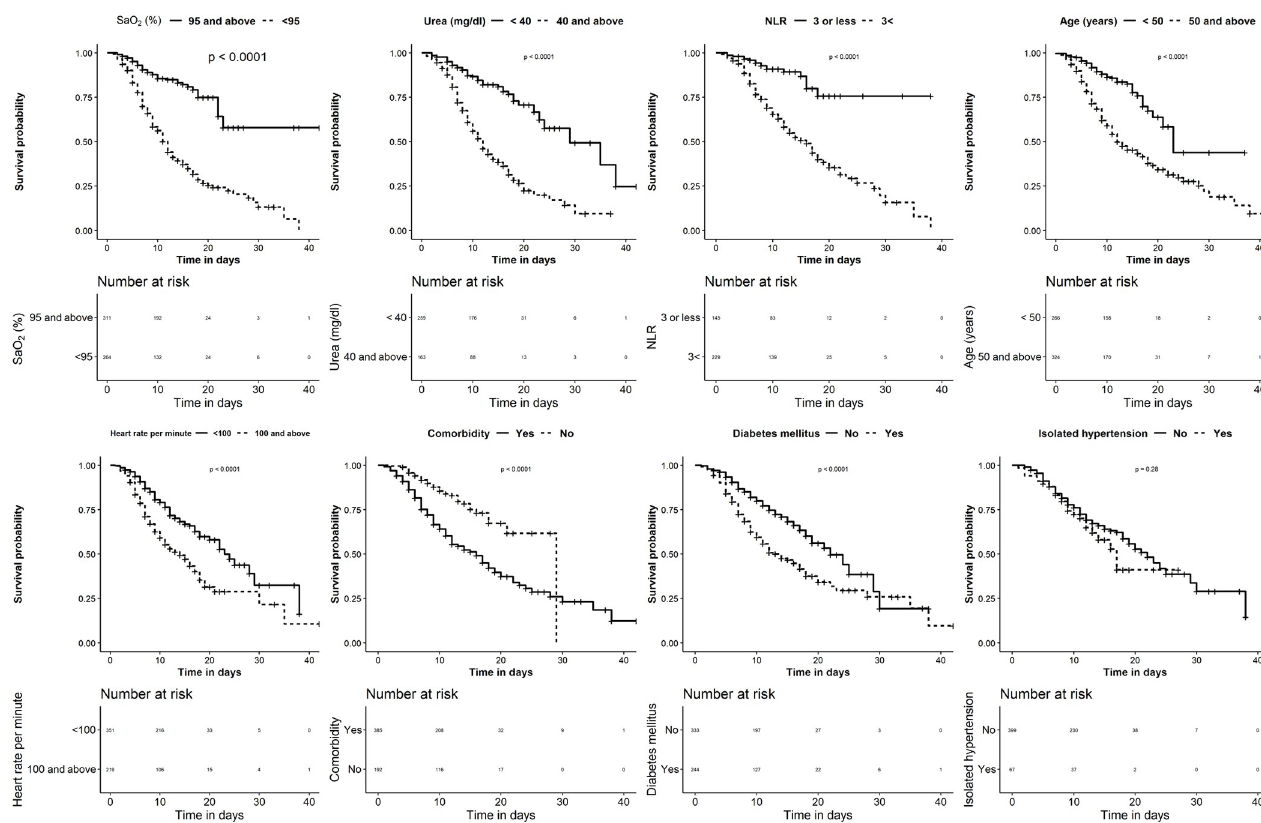
Fig 1. Kaplan-Meier analysis of the parameters significantly attributing to risk of mortality in the univariate analysis. Kaplan-Meier mean survival estimates for the time to mortality censored at 40 days. The numbers given above reflect the number of individuals who were alive at that particular time point in days, with or without the risk factors evaluated. Significance was computed using the log-rank test. Definition of Abbreviations: SaO 2 -Peripheral Oxygen Saturation, NLR-Neutrophil-to-Lymphocyte Ratio, BPM-Beats per minute.